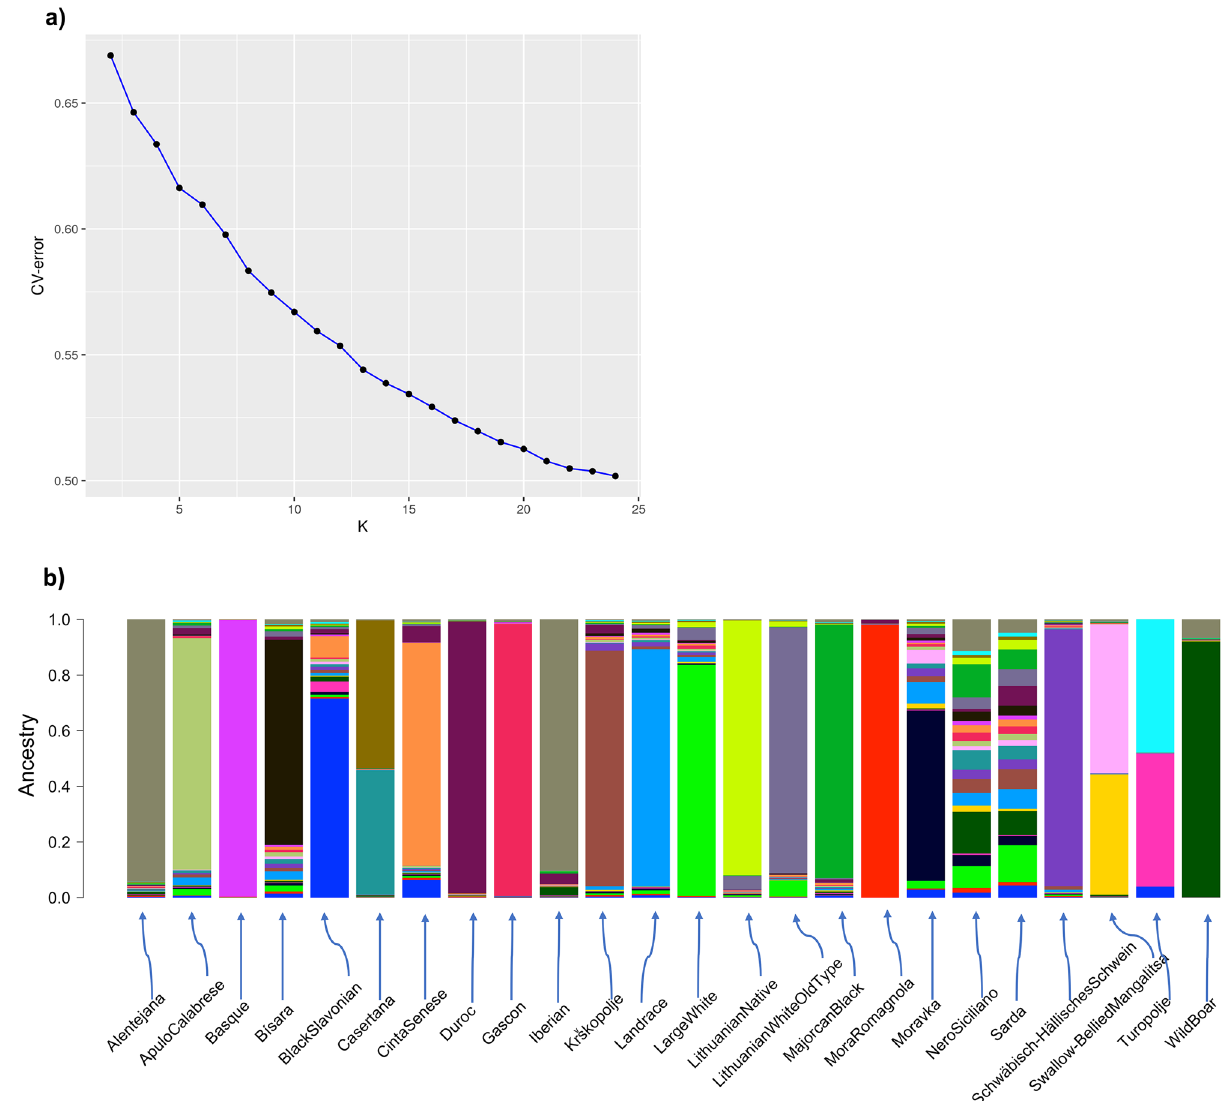
Figure 2. Results of admixture analysis: ( a ) fivefold cross-validation minimum error from K = 2–24; ( b ) summary per breed of admixture ancestries at K = 24.